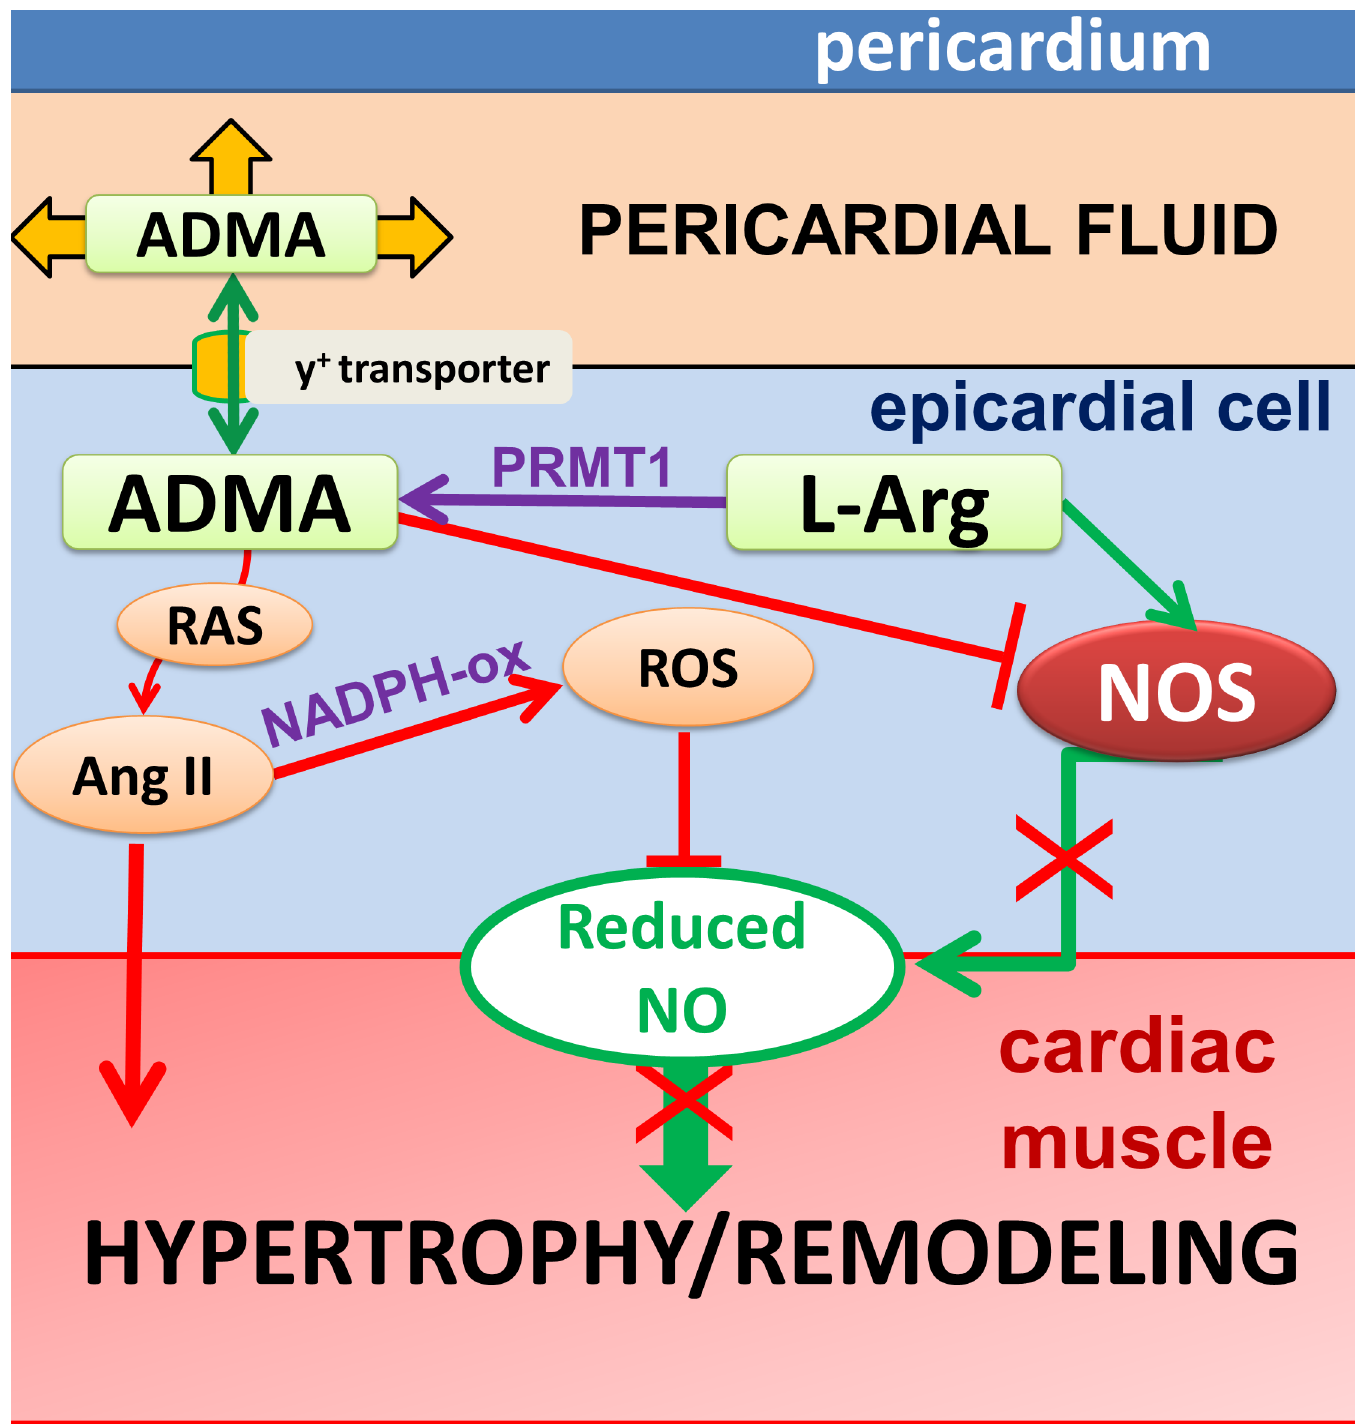
Fig 5. Proposed mechanisms by which elevated level of ADMA in pericardial fluid elicits hypertrophy/remodeling of cardiac muscle: accordingly, reduced NO bioavailability and increased level of Ang II together leads to development of cardiac hypertrophy/remodeling. ADMA – asymmetric dimethylarginine, NO – nitric oxide, NOS – endothelial NO synthase, RAS – renin-angiotensin-system, Ang II – angiotensin II, ROS – reactive oxygen species.